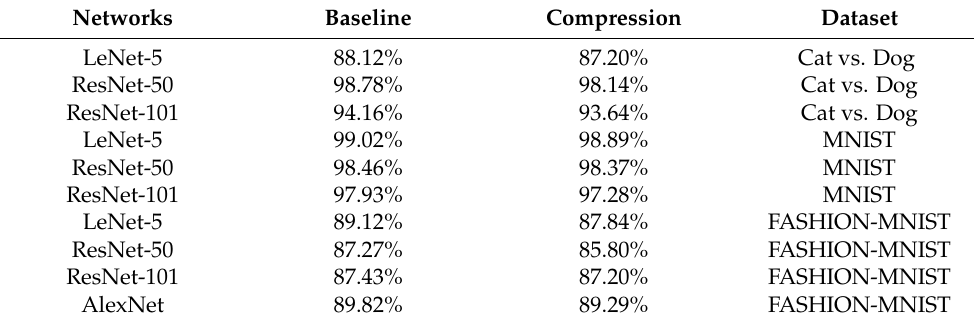
Table 1. The accuracy of three CNNs with different datasets and with clusters for